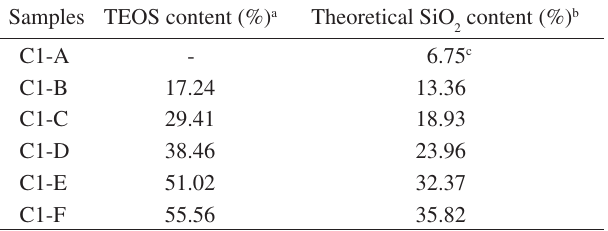
Table 1. Inorganic content in PU-1 after reaction with hTEOS (C1) and theoretical values of SiO . 2